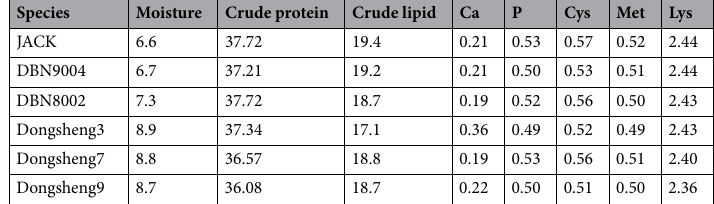
Enzyme activity analysis measurement. The liver, spleen and head kidney tissues were weighed and homogenized with a ninefold volume of normal saline using a homogenizer. The lactate dehydrogenase (LDH), total antioxidant capacity (T-AOC), total protein (TP), aspartate aminotransferase (AST) and alanine ami- notransferase (ALT) in the tissue homogenate were measured at 450 nm by a fluorescence microplate reader using commercial kits (NanJing JianCheng Bioengineering Institute, NanJing, Jiangsu, China). Evaluation of growth parameters performance. At the end of the eight-week experiment, the body length and weight were recorded from five fish per aquarium tank, with five tanks in each group (n = 25). The experimental fish were sacrificed, and the internal organs (e.g., heart, liver, stomach, intestine, kidney, spleen, gonad and swim bladder) were then weighed and recorded to calculate the growth parameters and morphologi- cal indices using the following Equations: Survival rate ( SR, % ) = N t / N 0 × 100%